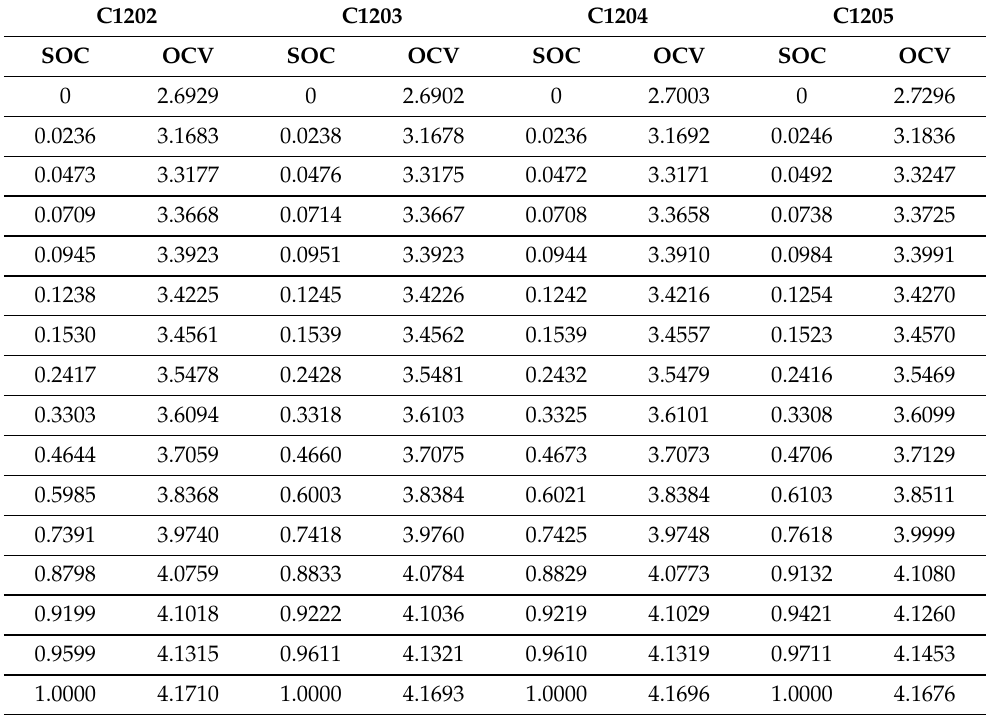
Table 4. Tabular OCV model.